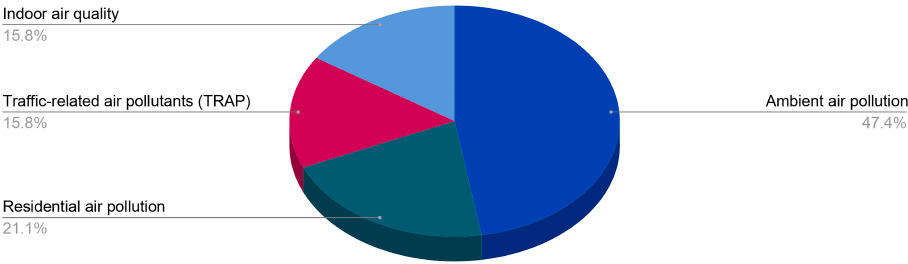
Figure 4. Categories of Air Pollution in the Literature.